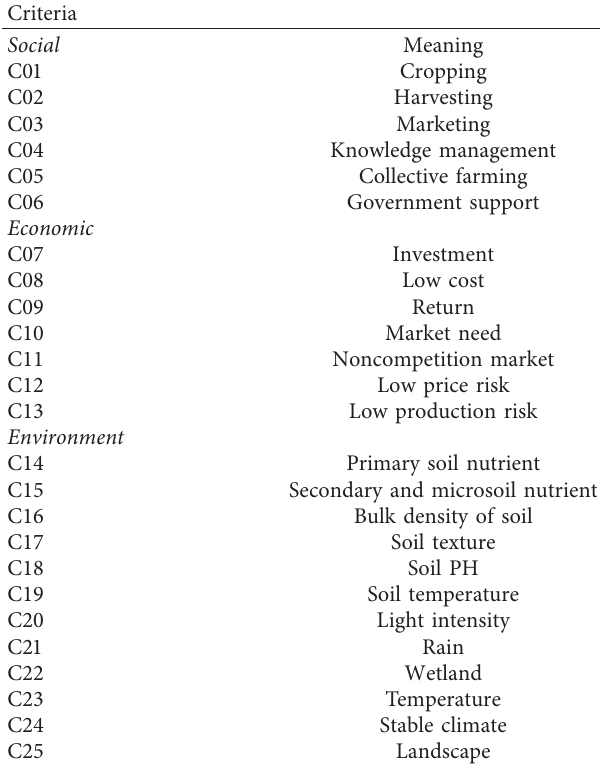
Table 3: List of criteria of the decision-making process. Criteria